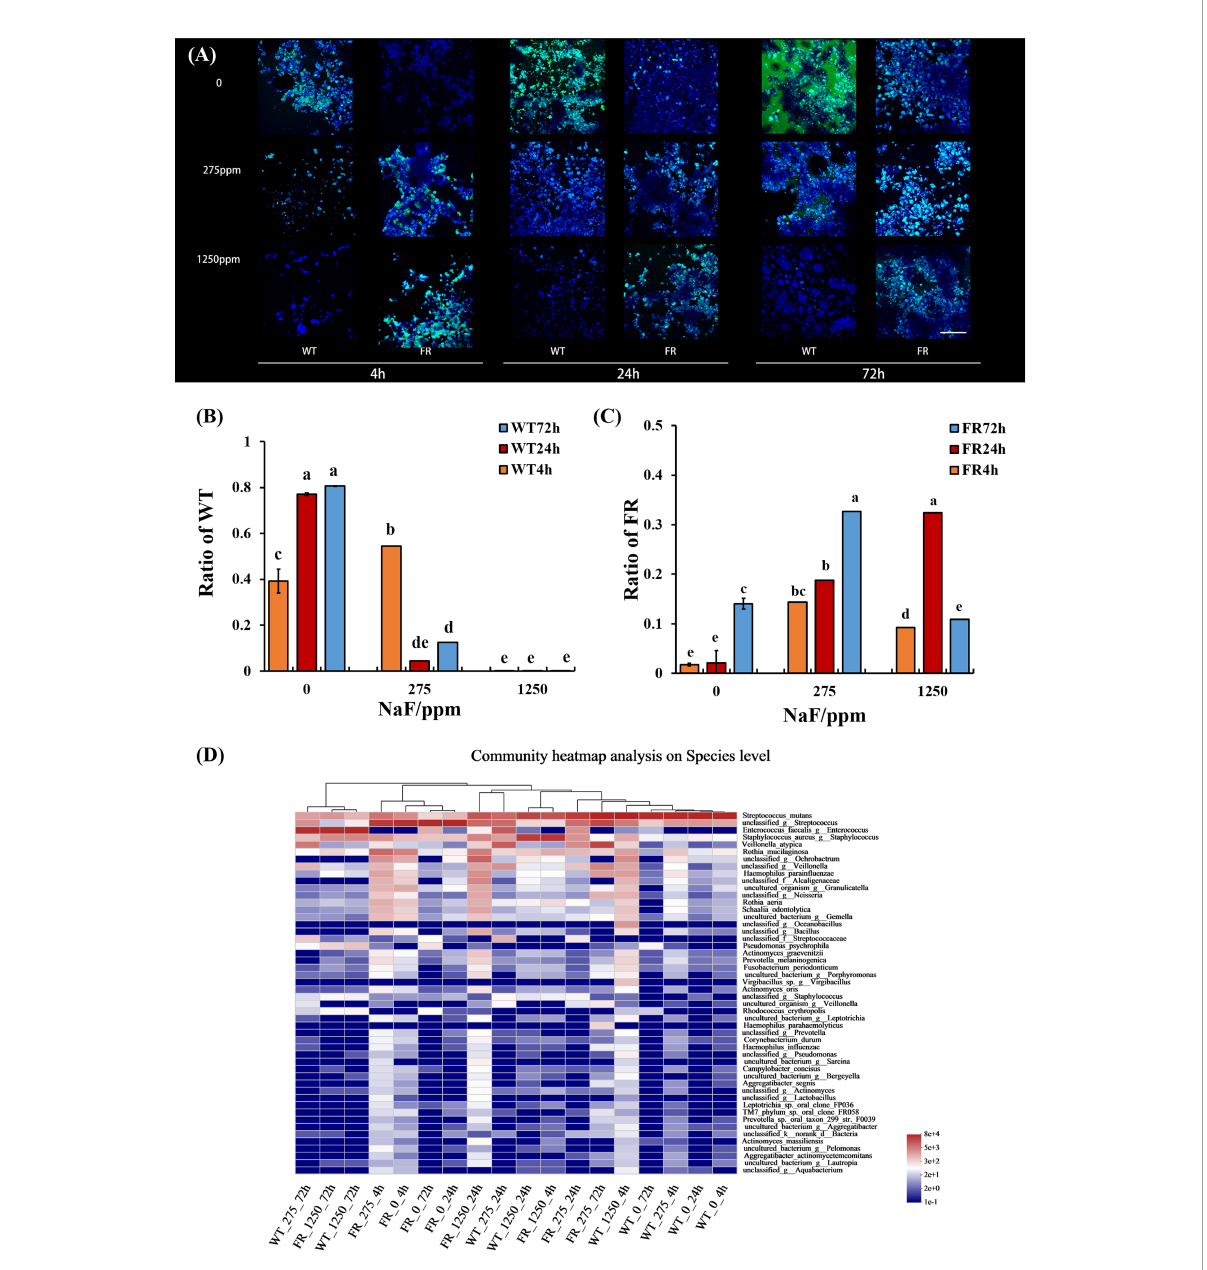
FIGURE 4 S. mutans ratio in bio fi lm and relative abundance of the 50 most predominant oral bacteria at the species level. (A) S. mutans within bio fi lms revealed by FISH; S. mutans was stained green, and all bacteria were stained blue, the scale bar 50 m m. (B) WT ratio revealed by qRT-PCR. (C) FR ratio revealed by qRT-PCR. (D) Relative abundance of the 50 most predominant oral bacteria at the species level. Data are presented as mean ± standard deviation, and different letters demonstrate a signi fi cant difference between groups (P <